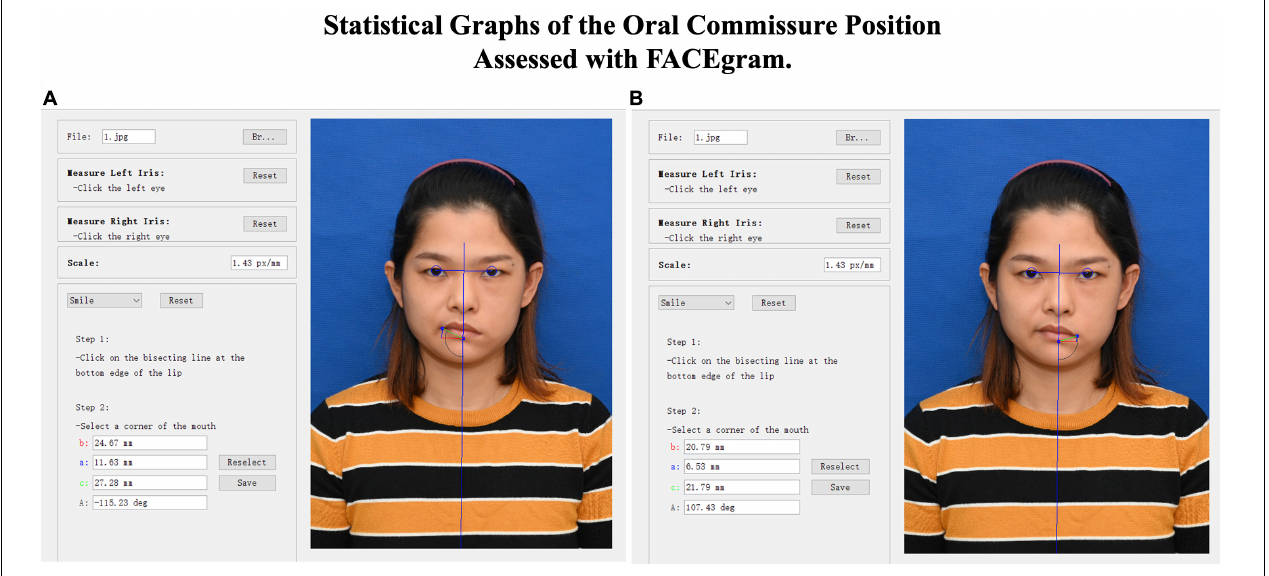
FIGURE 1 | FACEgram was used to quantitatively assess the unaffected (A) or paralyzed (B) side of the oral commissure at rest. The bilateral pupil and midpoint were used to establish a coordinate system. The o a-score ”coreinate system. Thfrom the oral commissure perpendicular to the horizontal line at the bottom edge of the lower lip (blue line). The “ b-score ”corefrom the oral commissure perpendicular to the vertical line (red line). The “a c-score ”corefrom the oral commissure to the bottom edge of the lower lip (green line). The photo shows the static outcome of a 31-year-old woman at 1 year postoperative. The difference in bilateral oral commissure ( c dif = 5.48) was determined by the unaffected ( c ua = 27.28) minus the paralyzed ( c p = 21.79) oral commissure positions ( c dif = c ua - c p ).